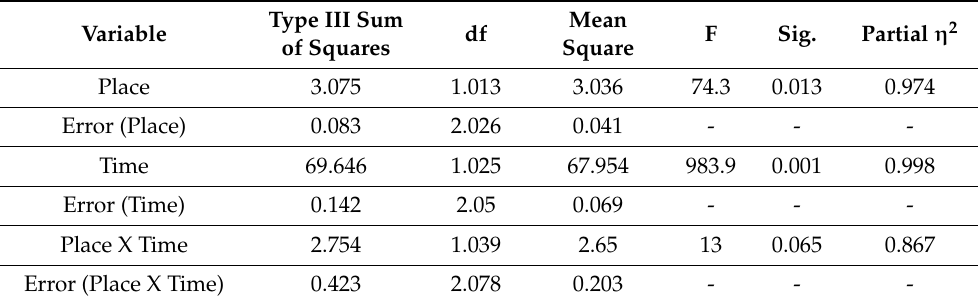
Table 3. Tests of within-subjects effects of goldenrod stem mass loss (g) in Lake Hévíz and through Hévíz canal.